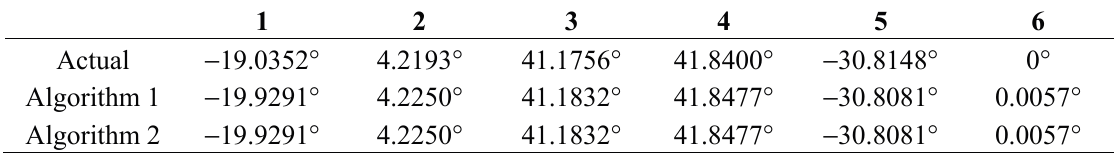
Table 7. Alignment results of the six simulations (pitch).